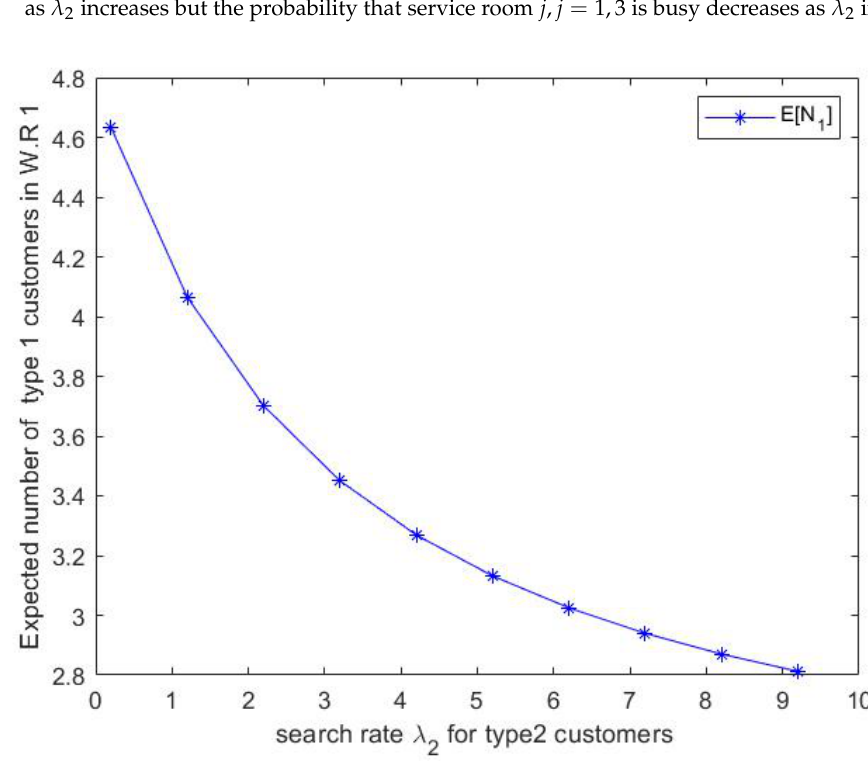
Figure 8. Effect of λ 2 on expected number of type 1 customers in the waiting room